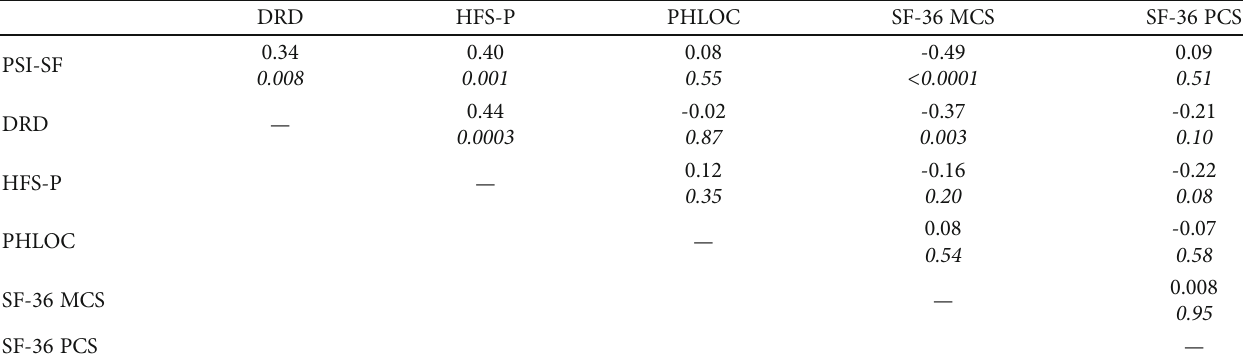
Table 3: Correlation between scale scores at time Baseline (Spearman ’ s correlation coe ffi cients and p values).